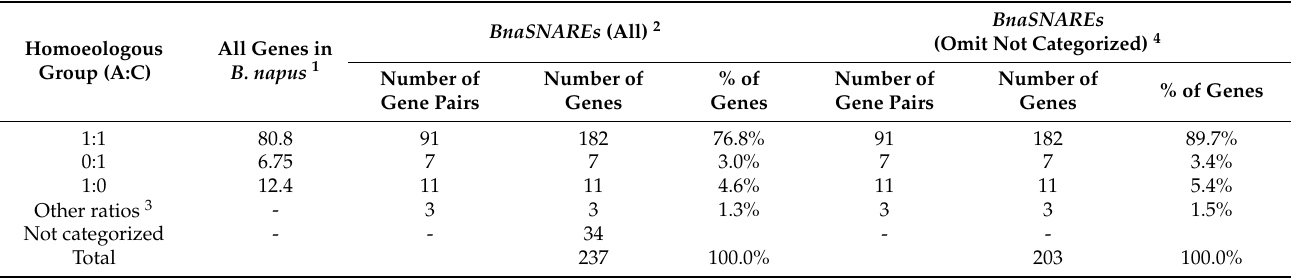
Table 1. Homologous gene pairs of SNAREs in B. napus .